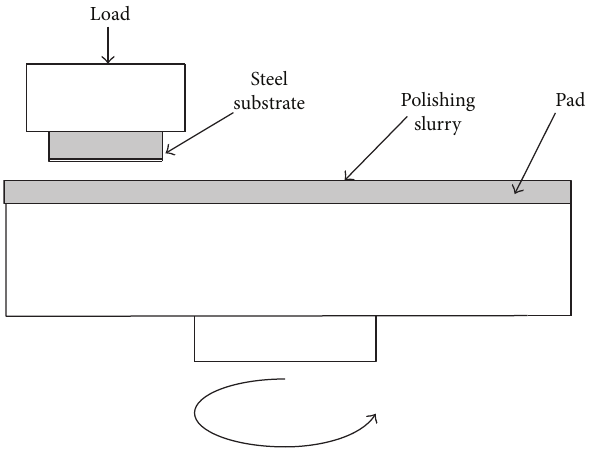
Figure 2: Schematic representation of the CMP. Table 2: CMP test